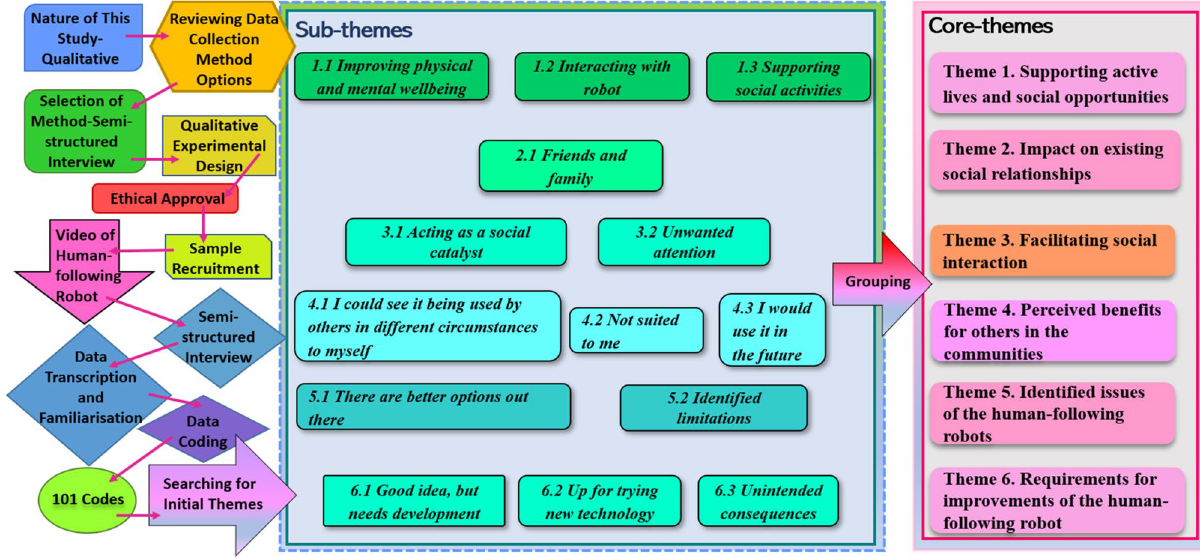
Figure 4. Illustration of research process and the thematic